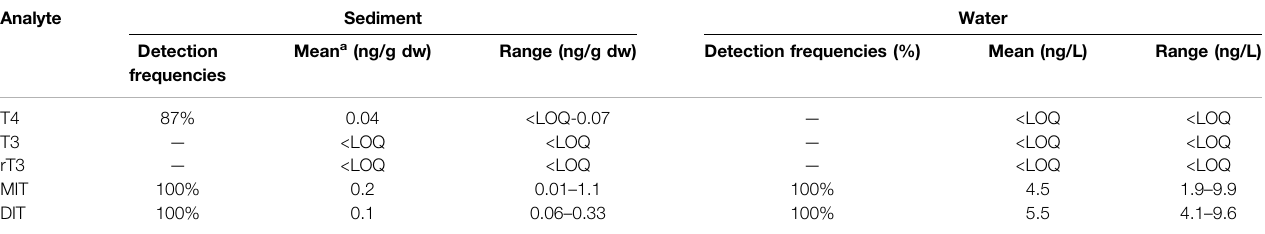
TABLE 3 | Detection frequencies and concentrations of thyroid hormones in water and sediment samples from Taihu Lake.